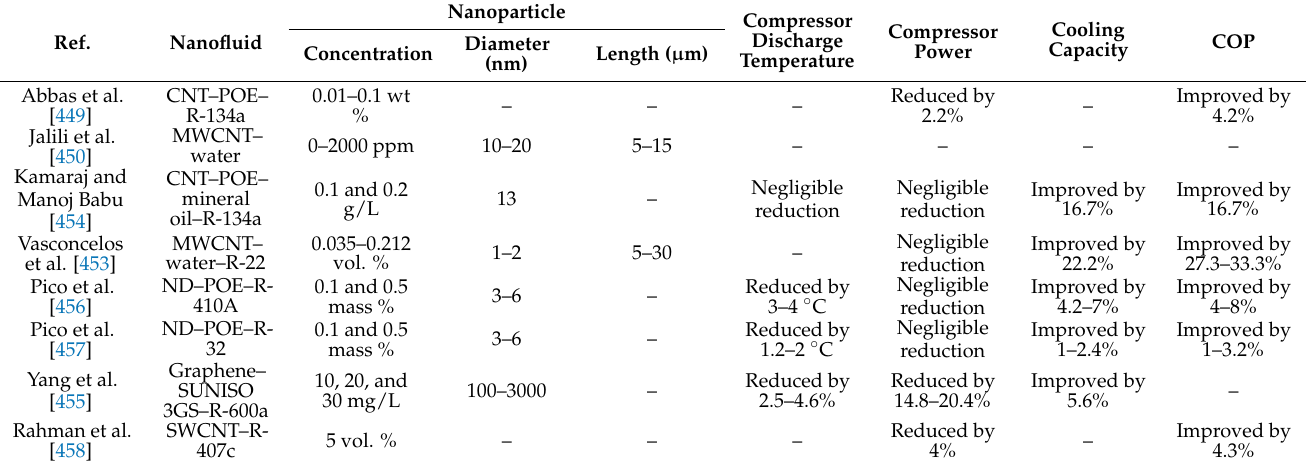
Table 11. List of studies related to carbon-based nanoparticles effect on AC&R systems performance.